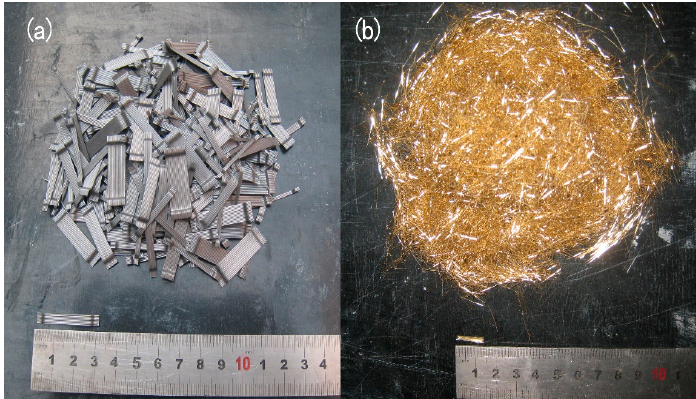
Figure 1. Steel fibers of ( a ) straight fiber and ( b ) hooked end Figure 2. Steel fibers of ( a ) straight fiber and ( b ) hooked end fiber. Table 2. Mechanical properties of steel fibers.